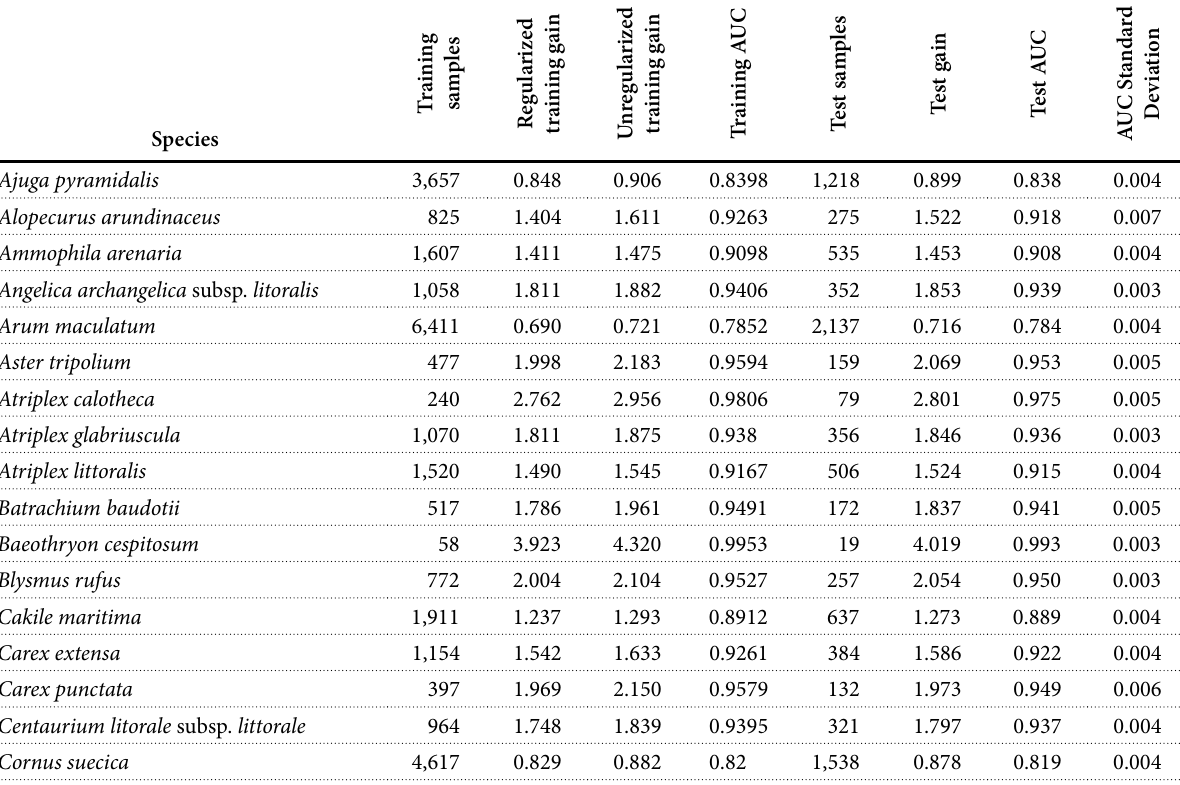
Tab. 2 Vascular plant species characterizing Pomerania: statistical evaluation of MaxEnt model (AUC – area under ROC curve).